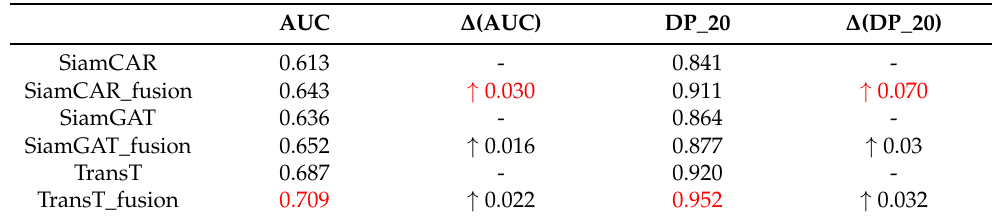
Table 6. AUC score and the DP_20 value of the SiamCAR_fusion tracker, the SiamGAT_fusion tracker, the TransT_fusion tracker, the SiamCAR tracker, the SiamGAT tracker, and the TransT tracker. The best value is labeled in